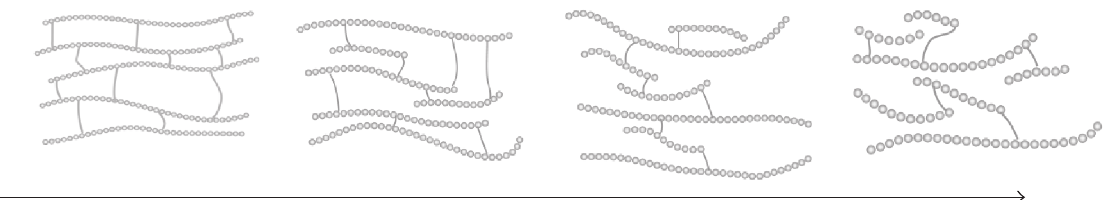
Increasing ratio of hydrolyzed whey protein isolate Figure 3: Protein network structure in WPI-based films with increasing ratio of h-WPI (on the left: BioZate10 0; on the right: BioZate5 5).